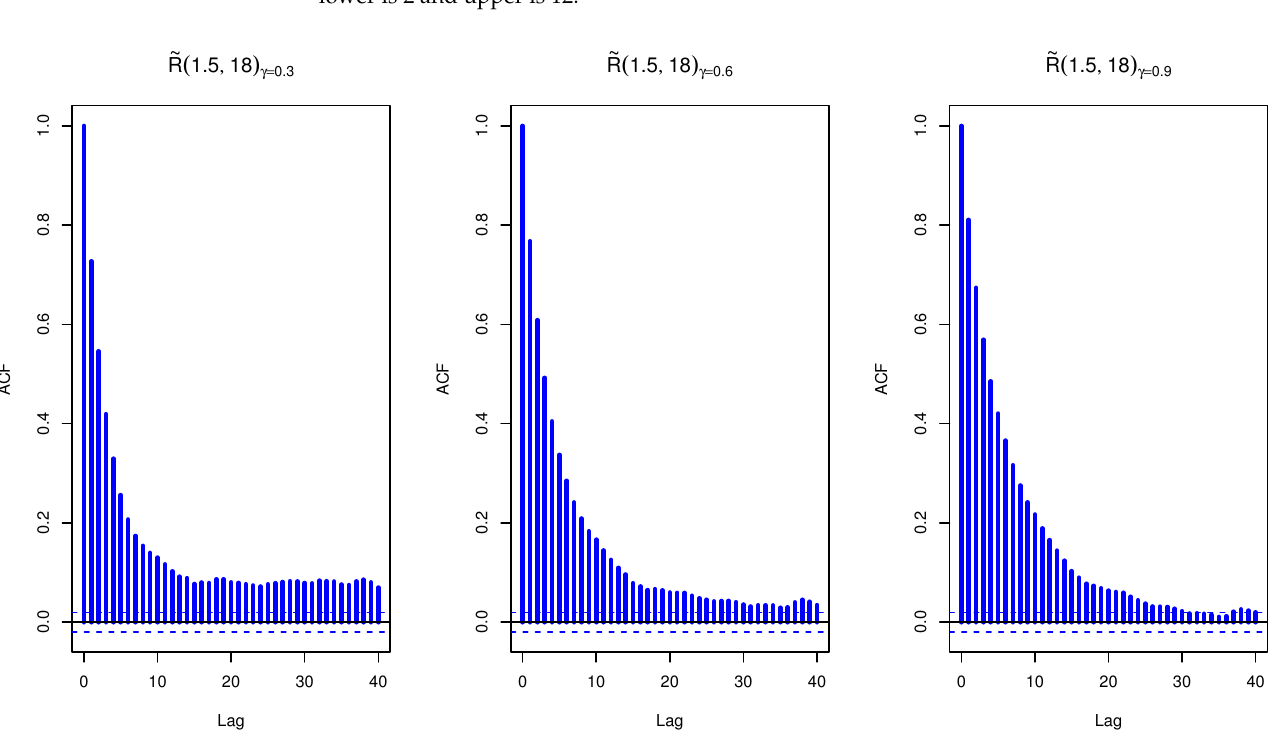
Figure 5. The auto-correlation plot of MCMC for fuzzy reliability ˜ R of TIIHLW distribution where lower is 2 and upper is 12.